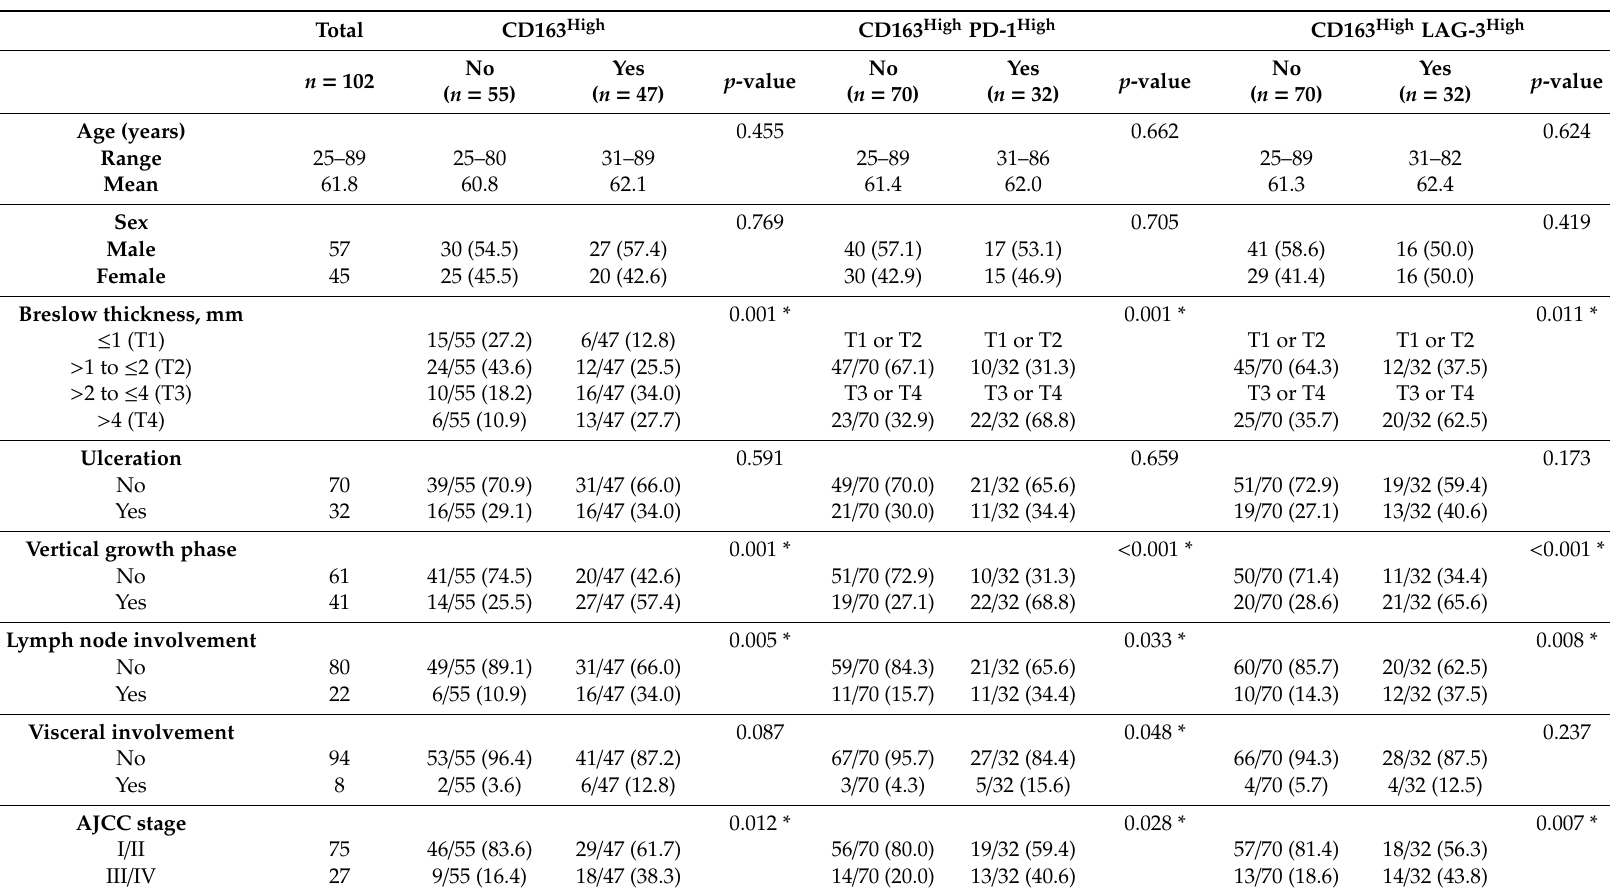
Table 1. Clinical-histopathological characteristics of the 102 cutaneous melanomas related to CD163, PD-1, and LAG-3